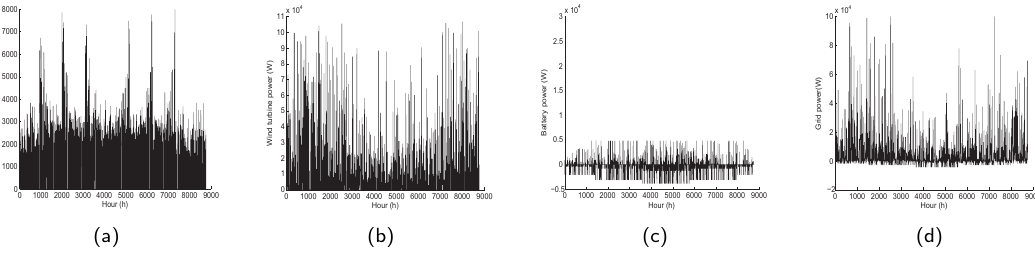
Figure 8. Power generation in mode II. ( a ) PV; ( b ) wind generator; ( c ) battery; and ( d ) power